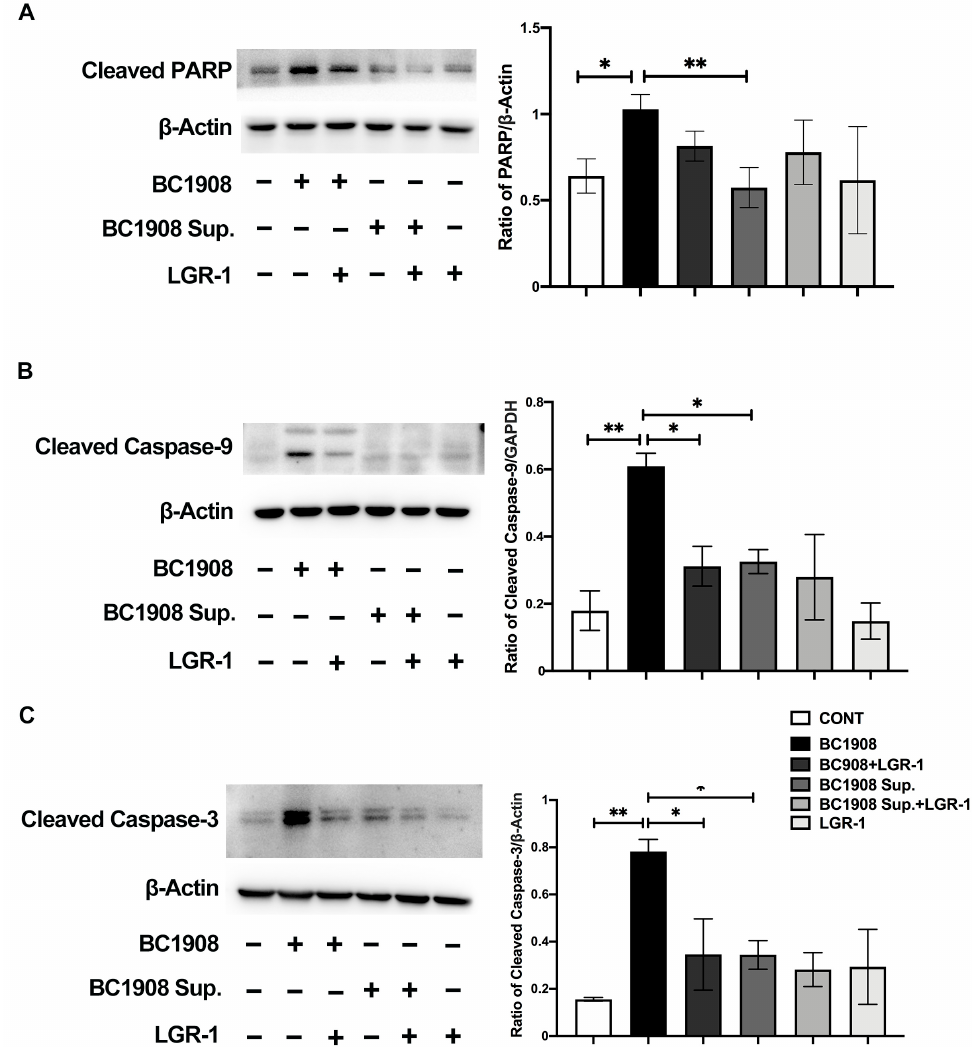
Figure 5. LGR-1 prevents the activation of BC1908 and the BC1908 supernatant on the apoptotic proteins of endometrial epithelial cells. ( A – C ) Proof of B. cereus activates the apoptosis pathway, and LGR-1 relieves the activation of the apoptosis pathway. (* p < 0.05, ** p <